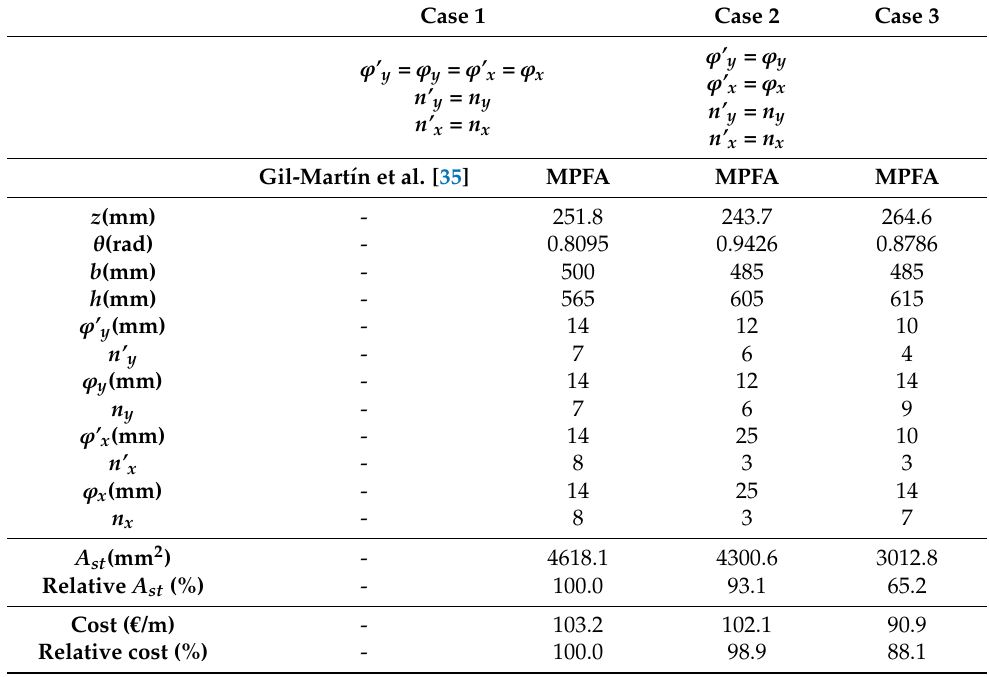
Table 8. Optimal design solutions with variable section.